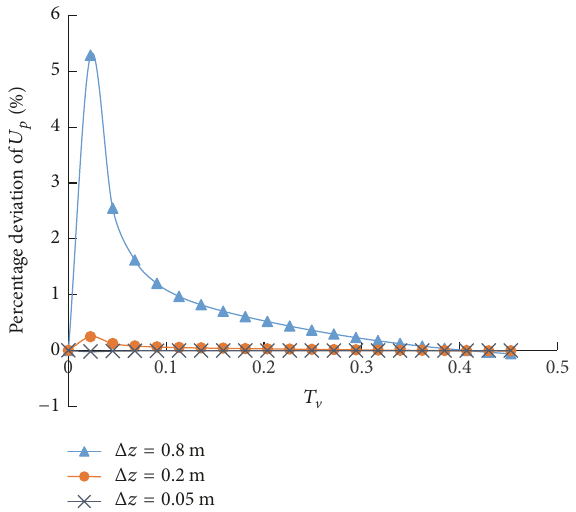
Figure 5: Percentage deviation of 𝑈 𝑝 between the FAM and the semianalytical solution versus 𝑇 V curves for constant loading.